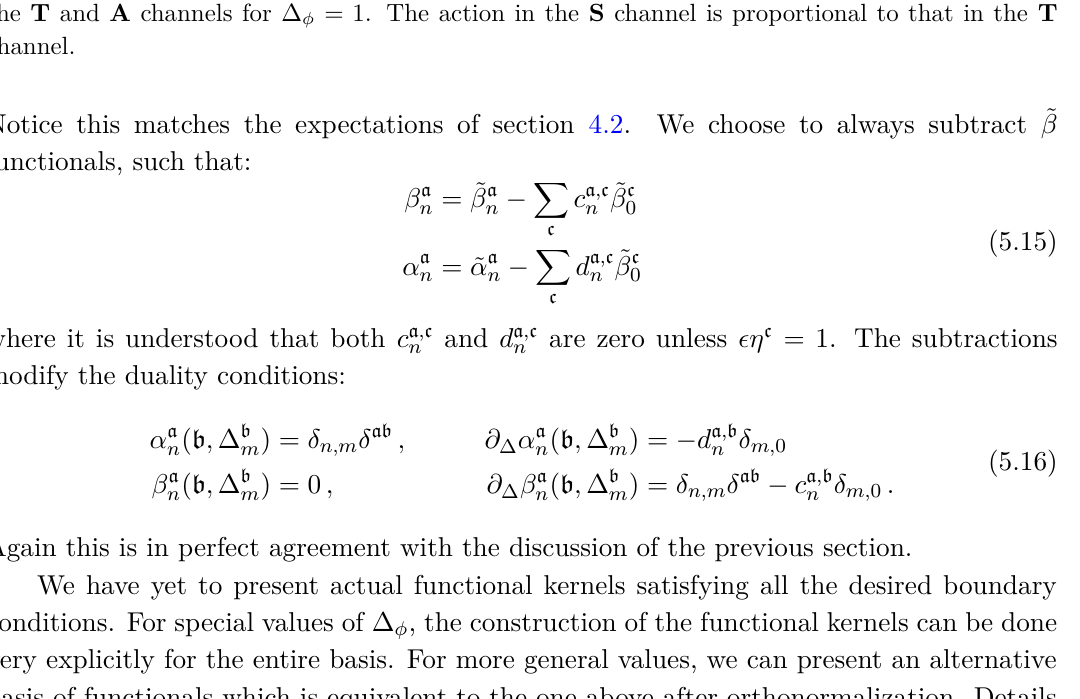
. We consider the O ( n ) case with n = 3 and plot its action in 0